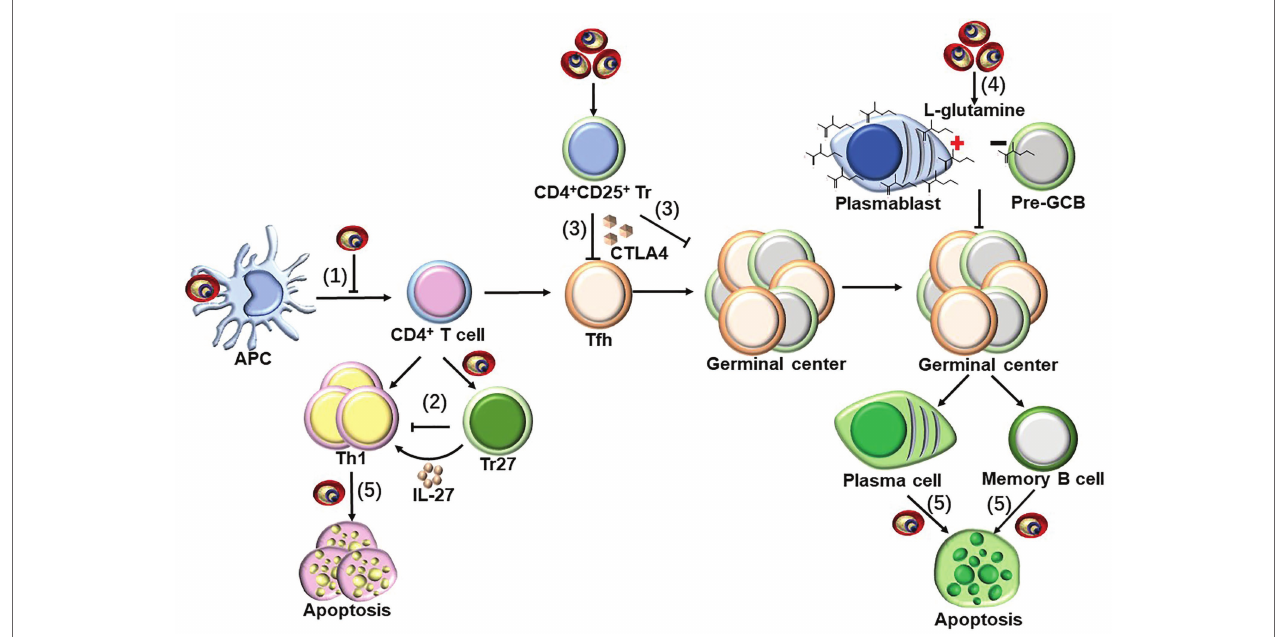
FIGURE 3 | Strategies to suppress host immune response by blood-stage malaria parasites. Parasite-specific CD4 + T cells are essential for host protective immunity against blood stage, as which can not only directly clear parasite through secretion Th1 cytokines but also provide help for B cells to produce antibody. However, malaria parasites have evolved to evade host immune response through following strategies. (1) pRBCs could inhibit the maturation of DCs, and subsequently suppress the CD4 + T cell activation (Urban et al., 1999; Woodberry et al., 2012; Pinzon-Charry et al., 2013). (2) Tr27 cells, the IL-27-producing CD4 + T cells, have also been reported to be activated during malaria infection, which reciprocally suppresses CD4 + T cells activation through the secretion of IL-27 (Kimura et al., 2016). (3) Malaria infection also induce the expansion of CD4 + CD25 + regulatory T cells, which interfere T helper cell responses and follicular T helper (TFH)-B cell interactions in germinal centers through secretion of CTLA-4 (Kurup et al., 2017). (4) The early differentiation of parasite-specific B cells into short-lived plasmablasts consumes a large amount of L-glutamine during malaria blood-stage infection, resulting in the nutrient deprivation of GCB, limiting the generation of MBC and LLPC responses against malaria parasites (Vijay et al., 2020). (5) The infection of malaria parasite could even induce the apoptosis of the activated CD4 + T cells dependent on IFN- γ , but both LLPCs and MBCs are deleted by an unknown mechanism (Hirunpetcharat and Good, 1998; Wipasa et al., 2001; Xu et al., 2002; Wykes et al.,